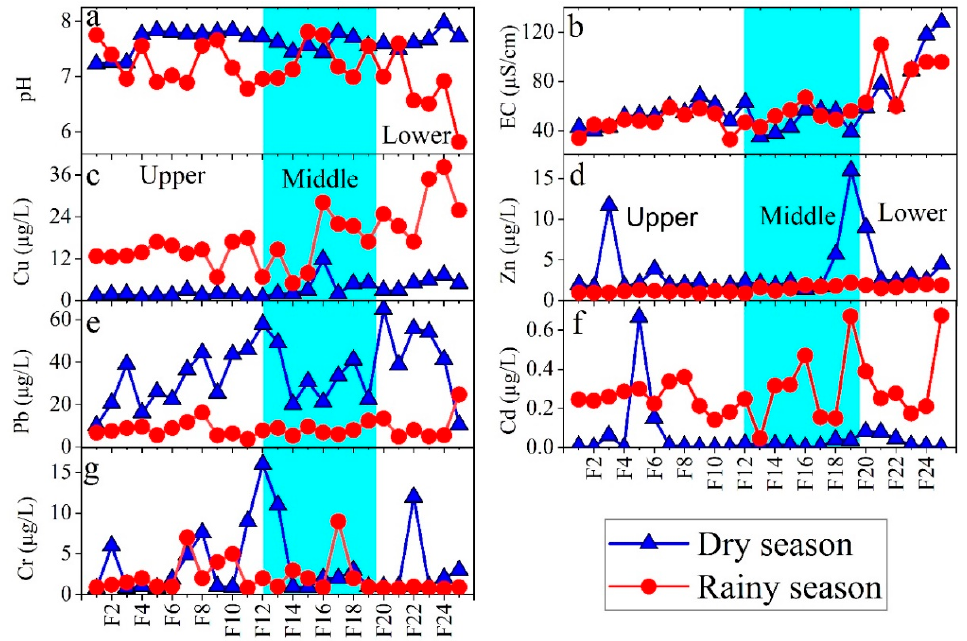
Figure 3. Spatial variations of ( a ) pH, ( b ) EC values, and ( c – g ) heavy metal concentrations along river flow.